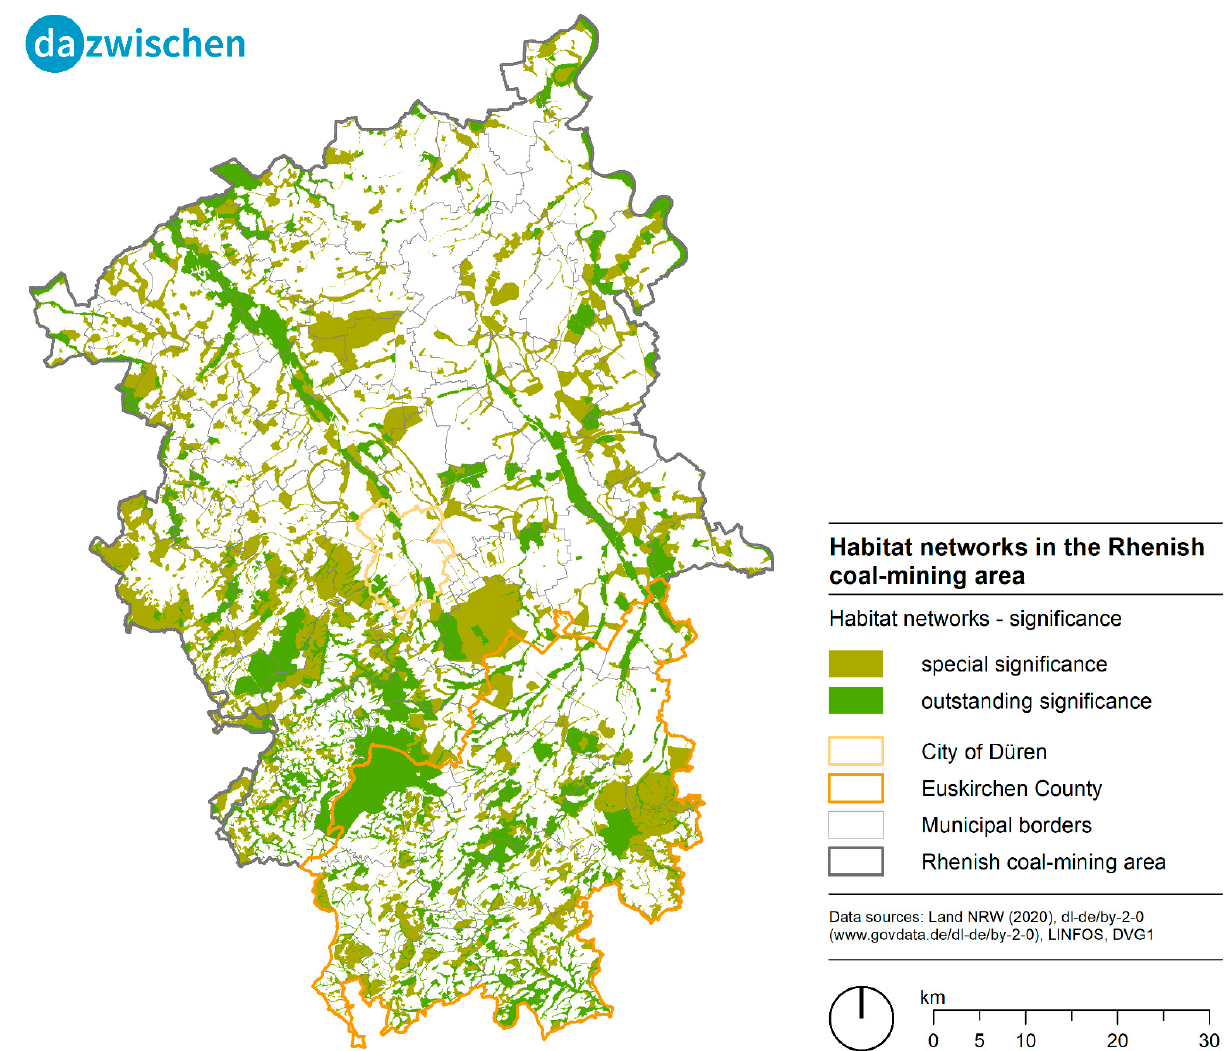
Figure 6. Habitat networks in the Rhenish coal-mining area. Source: own Figure.